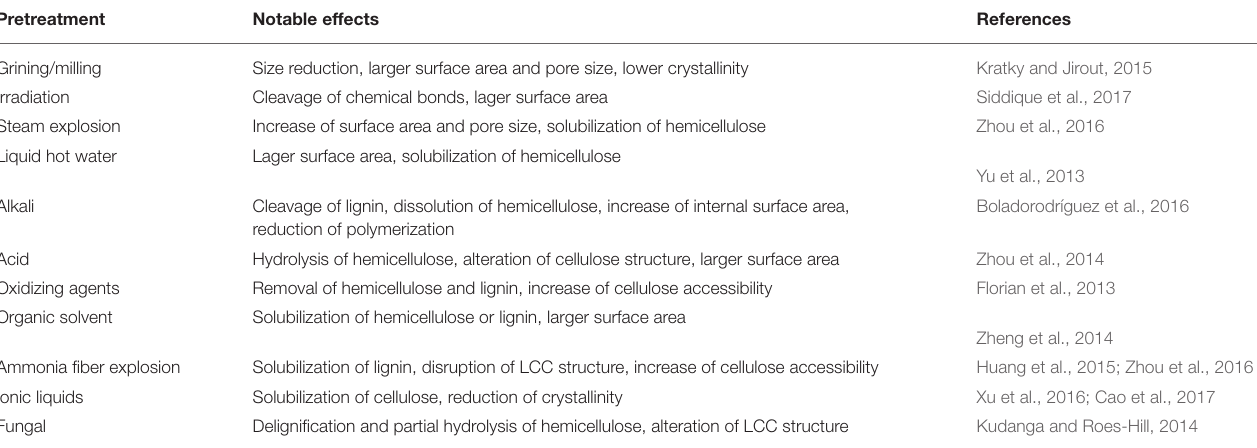
TABLE 4 | Conventional pretreatments and notable